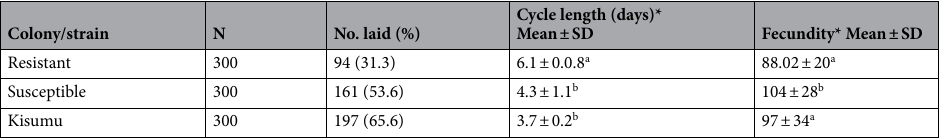
Table 1. Mean duration of gonotrophic cyle and fecundity of resistant and susceptible colonies of An.gambiae. The Gonotrophic cycle is the number of days from blood feeding to egg-laying. Fecundity is measured in the number of eggs laid per female. *Values representing the percentage of mosquitoes that laid eggs per colony, mean and standard deviations of gonotrophic cycle length in days and fecundity. The same superscript letters indicate no significant